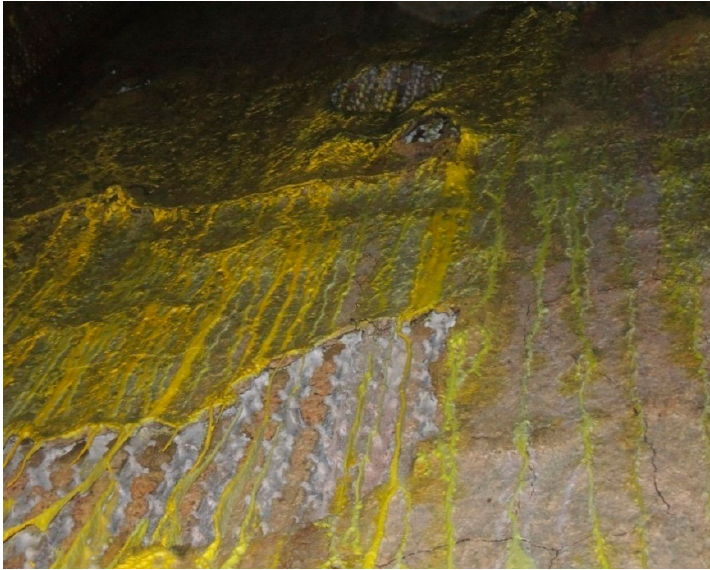
Figure 1. Corrosion of the refractory material by sodium salts in a waste liquid boiler.